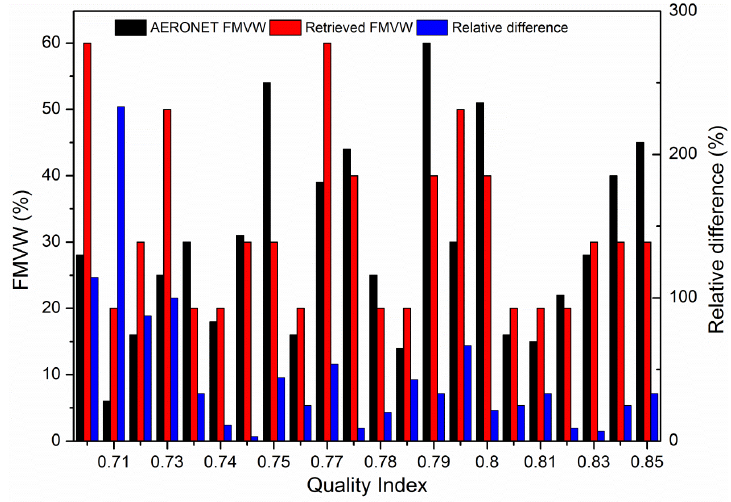
Figure 5. The variation of the FMVW retrieved from PARASOL, the FMVW obtained from AERONET, and the relative error as a function of the quality index. Note that the quality index ( X -axis) is not displayed linearly, but corresponds to the values of the 22